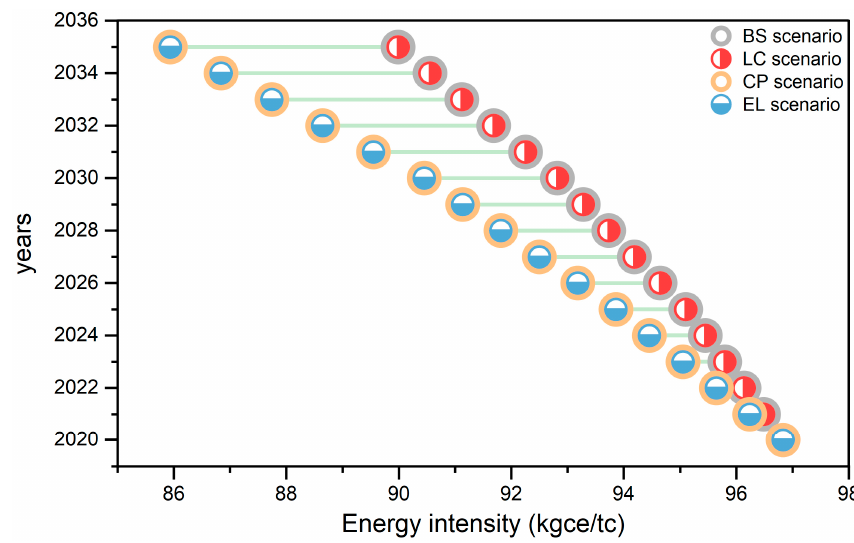
Figure 4. Energy intensity of cement industry in Shandong Province from 2020 to